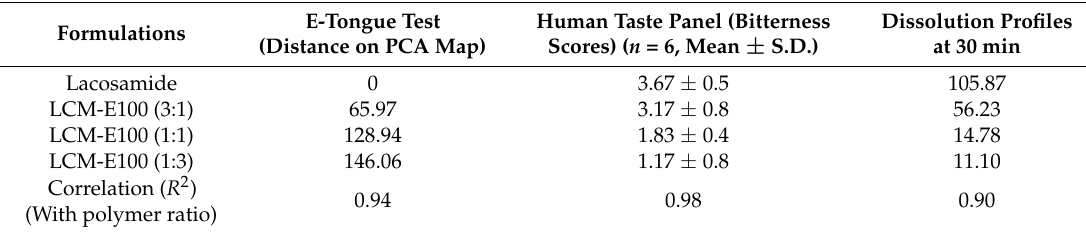
Figure 5. E-tongue test results (PCA map) of lacosamide, LCM-E100 (3:1), LCM-E100 (1:1) and LCM-E100 (1:3). Table 3. Particle size distribution of lacosamide, LCM-E100 (3:1), LCM-E100 (1:1), and LCM-E100